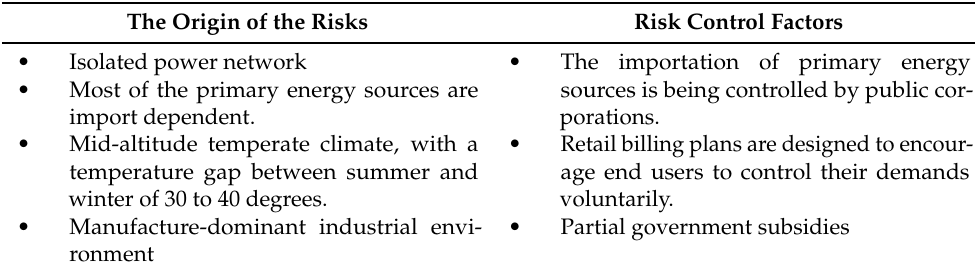
Table 2. The risk factors of the South Korean power